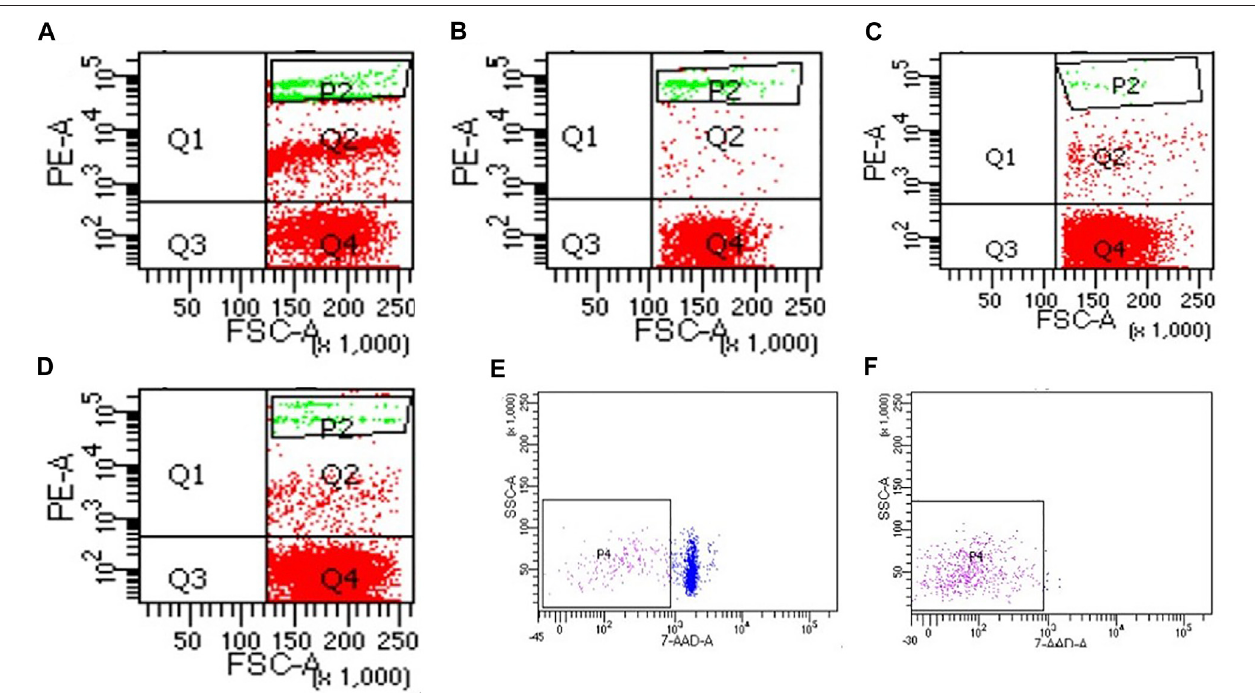
FIGURE8| Theeffectofdifferentcellpuri fi cationmethodsoncellaggregation. (A) Control, (B) Group1(magneticbeadscellsorting), (C) Group2(DNApuri fi cation magnetic beads), (D) Group 3 (Centrifugation on Percoll density gradient), (E) Control of group 4, (F) Group 4 (FACS).